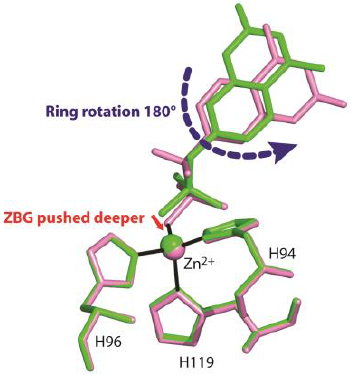
Figure 5. Structural superposition between compounds 1 (green) and 2 (pink) when bound to the hCA II active site.